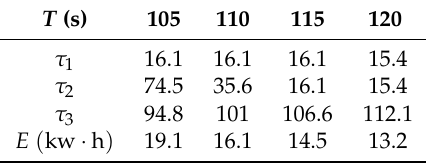
Figure 6. Optimal speed trajectories under different running times. ( a ) The speed trajectories w.r.t. the position; ( b ) The speed trajectories w.r.t. the time. Table 3. The optimal ¯ τ values and energy consumption of different running times T